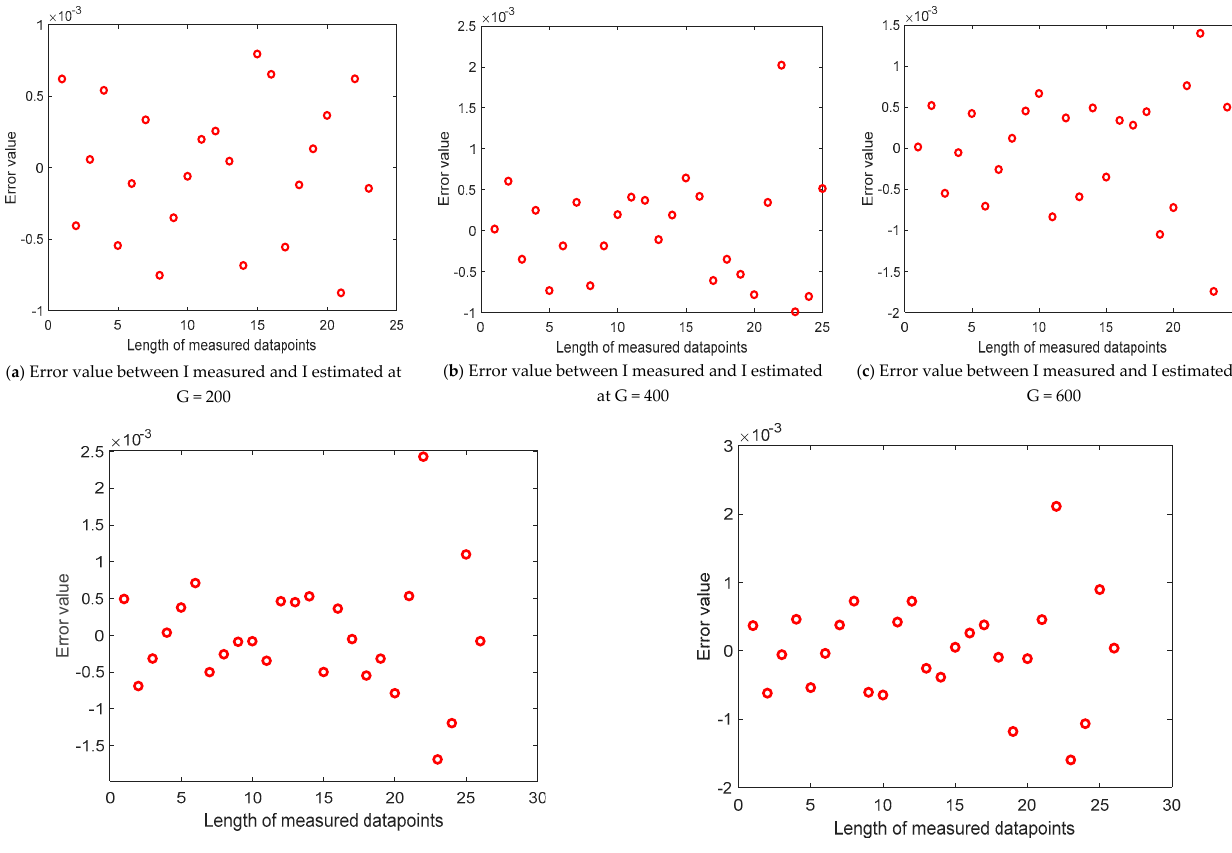
Figure 16. Depiction of the principal characteristics on ST40 module.